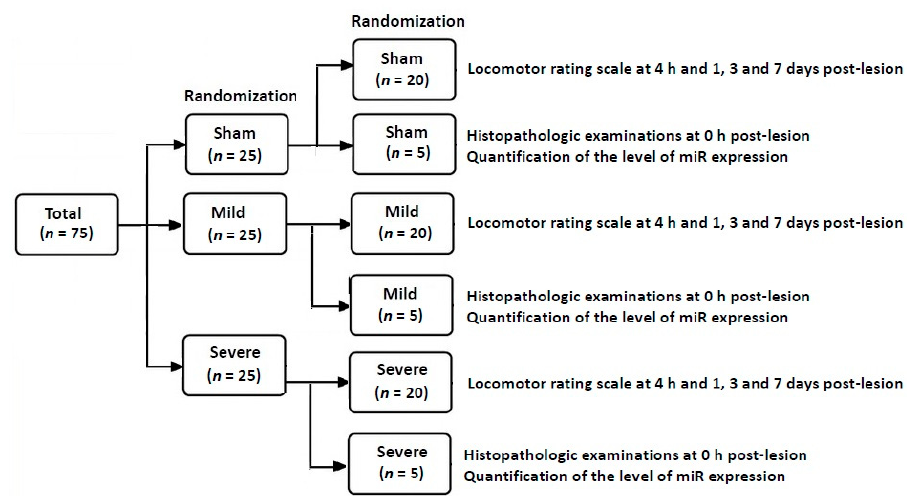
Figure 1. A schematic illustration of laboratory procedures.